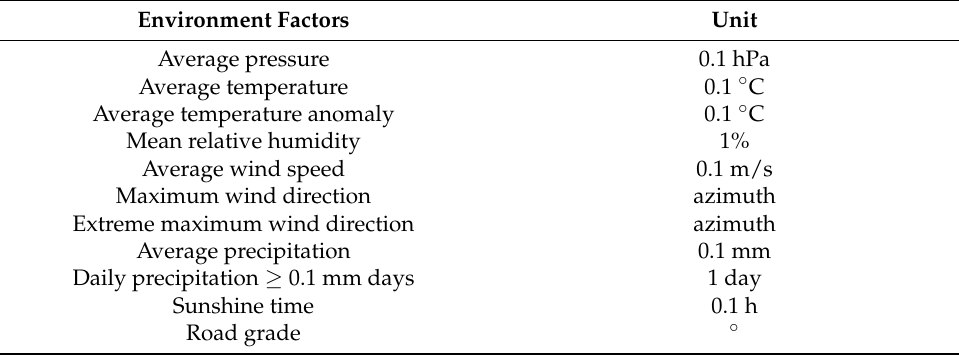
Table 6. Selected environment